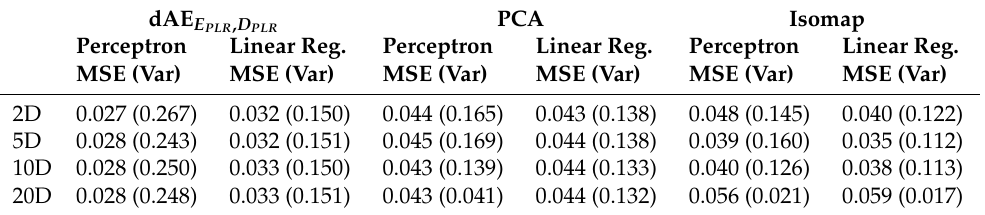
Table 6. Performance of the Combined model. MSE and Variance values are rounded to the third digit after the decimal